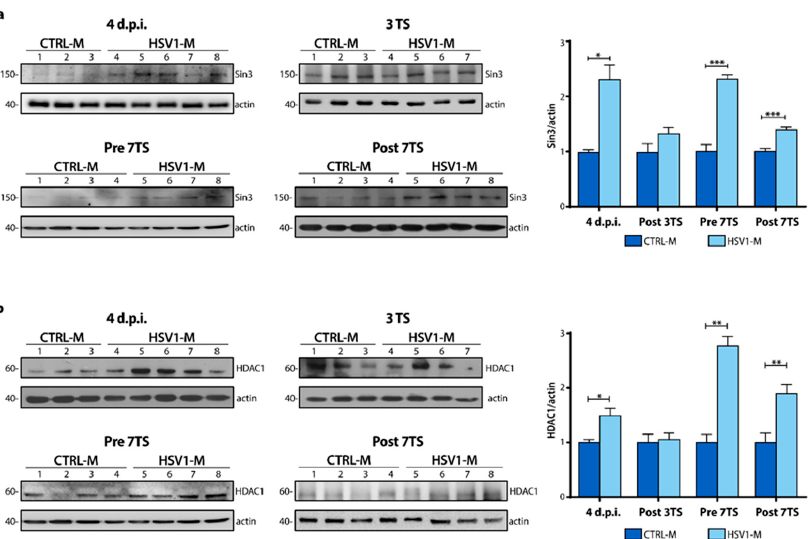
Figure 4. Recurrent HSV-1 infection induces an increase in Sin3 and HDAC1 protein expression. Representative WBs showing Sin3 ( a ) and HDAC1 ( b ) protein levels in the whole lysate from the cortices of 4 d.p.i., Post 3TS, Pre and Post 7TS mice. Densitometric analyses were performed with ImageLab software and normalized to H3 or tubulin expression. The values represent the normal- ized fold-changes in protein levels from HSV1-M with respect to CTRL-M. Data are mean ± SEM. * p < 0.05; ** p < 0.01; *** p < 0.001. Statistical significance was calculated by multiple t -tests and deter- mined using the Sidak–Bonferroni method, with alpha = 0.05.